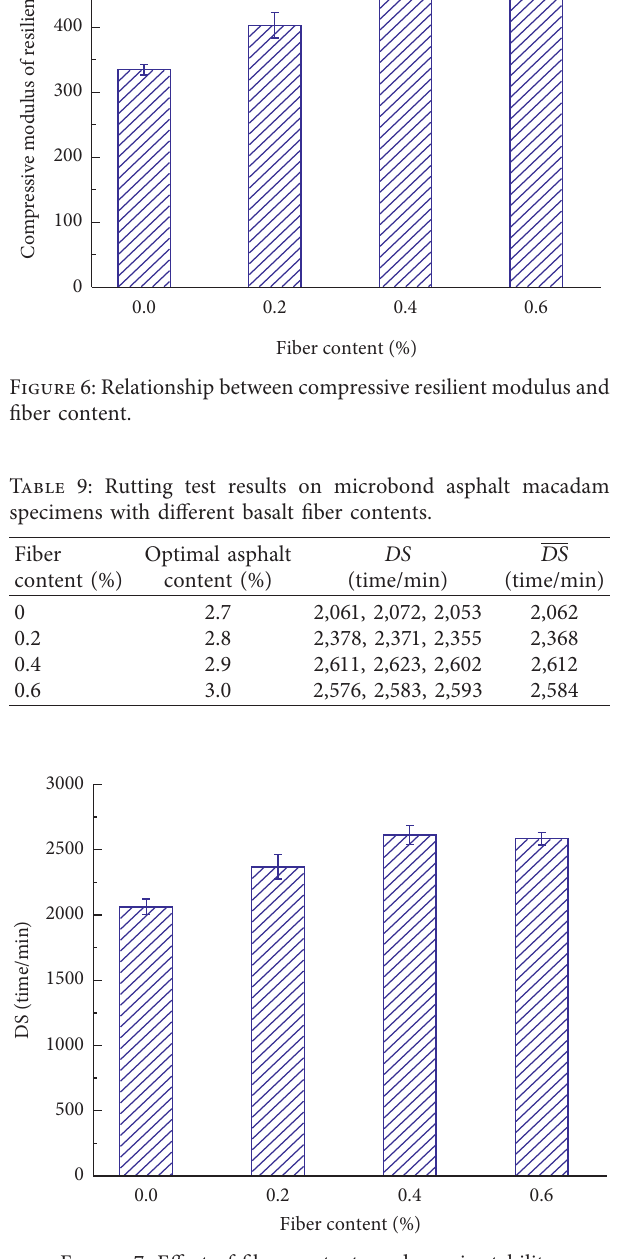
Figure 7: Effect of fiber content on dynamic stability.